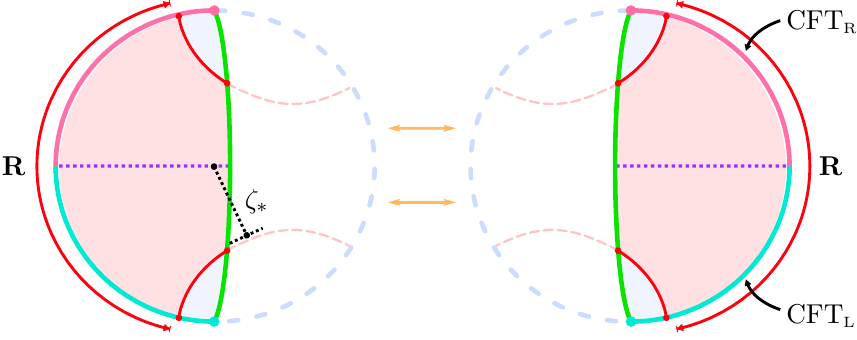
Figure 9. This figure shows how RT surfaces can intersect the brane before reaching the turnaround point ζ ∗ , with relatively small brane tension T o , i.e. θ